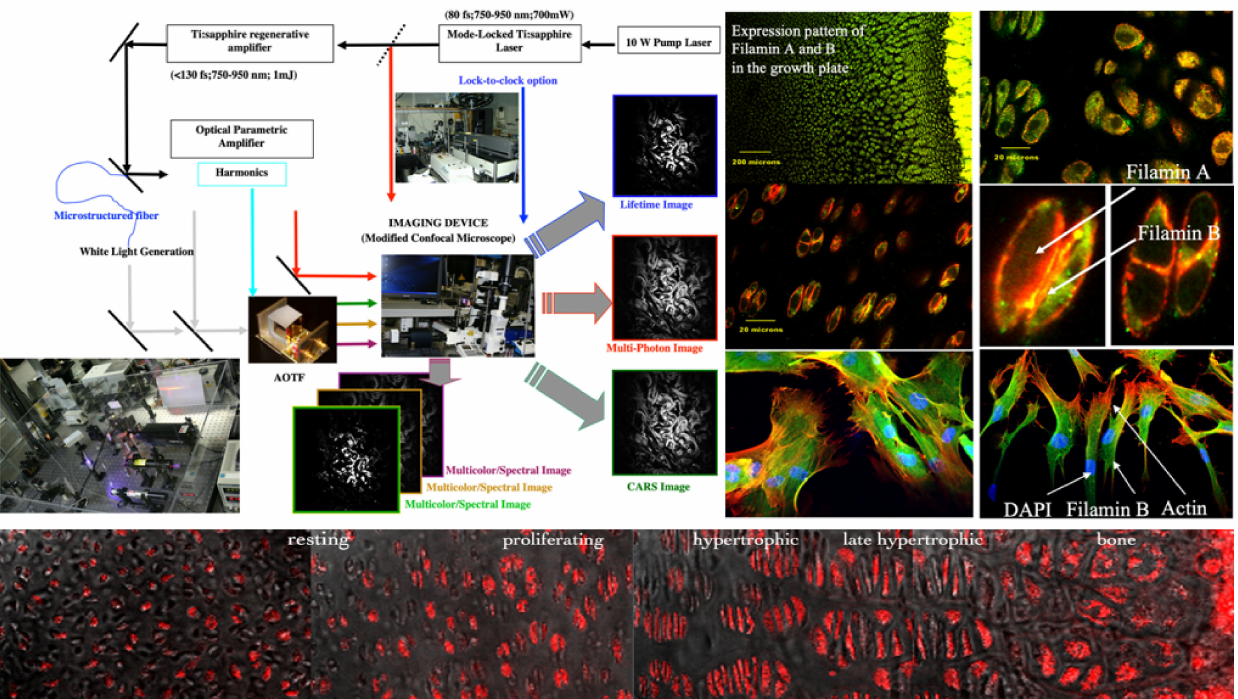
Figure 12. Multispectral microscopy setup and expression pattern of Filamins A and B in the growth plate. Topologically, filamin A (green) is distributed mainly in the hypertrophic zone and in the cytoplasm, while filamin B (red, bottom) is distributed along the growth plate, and in the cleavage furrow of dividing